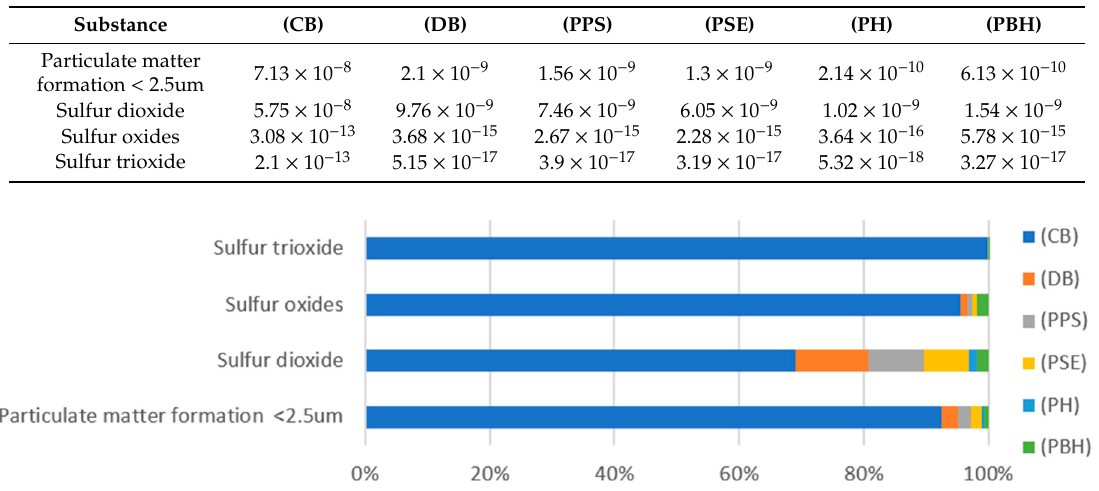
Figure 8. Results of environmental impact characterization for the category of particulate matter formation (DALY).